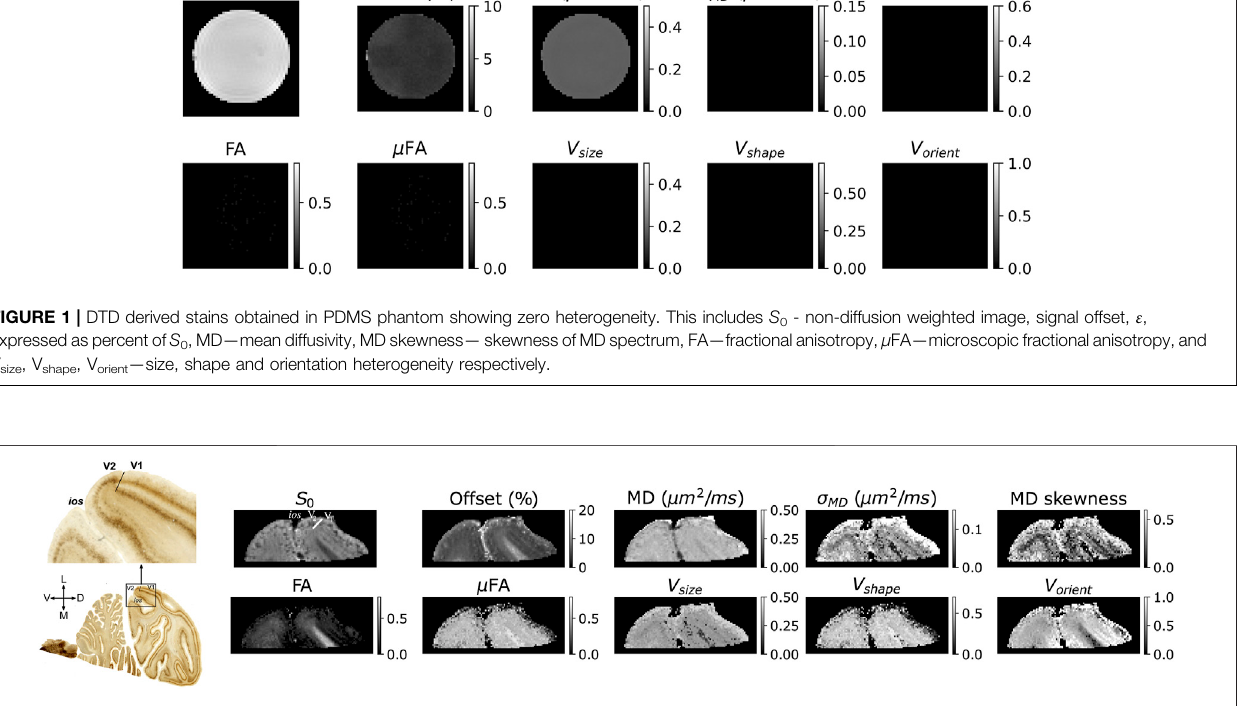
FIGURE2| DTDderivedstainsobtainedinaexcisedvisualcortexofamacaquemonkeyshowingmicroscopicanisotropyandheterogeneity.Approximatelocation in the macaque brain from which 10 mm ×5 mm × 5 mm piece was dissected for MR imaging shown using SMI-32 stained sections (highlights pyramidal neurons and their processes) in Saleem and Logothetis macaque brain atlas [50] in the left most column. The V 1 and V 2 areas of the visual cortex and inferior occipital sulcus (ios) are highlighted for reference. The DTD-derived stains shown include S 0 — non-diffusion weighted image, signal offset, ε , expressed as percent of S 0 , MD — mean diffusivity, MD skewness — skewness of MD spectrum, FA — fractional anisotropy, μ FA — microscopic fractional anisotropy, and V size , V shape , V orient - size, shape and orientation heterogeneity respectively.